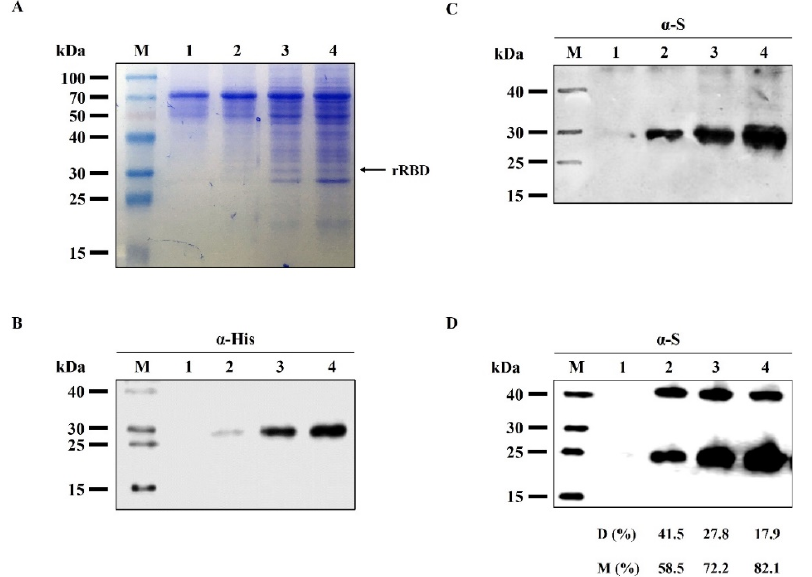
Figure 2. Analysis of rRBD in supernatants by SDS-PAGE under reducing ( A – C ) and non-reducing ( D ) conditions followed by western blot developed with anti-His ( α -His) and anti-S ( α -S) antibodies. Sf9 cells were infected with Acpolh-pSeL -gprRBD. At different days post-infection, the culture medium was harvested and analyzed. Lanes: 1–4, culture supernatant from 1–4 days post-infection; M, protein marker; D (%): ratio of dimer to total rRBD expressed as determined by densitometry analysis. M (%): ratio of monomer to total rRBD expressed as determined by densitometry